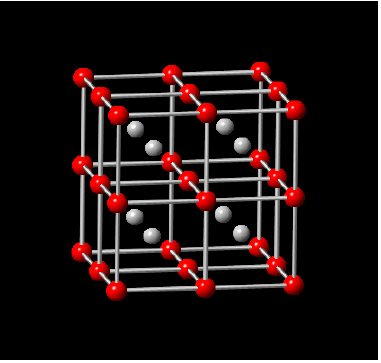
Figure 1. Schematic diagram of grid nodes of bilinear interpolation method for calculating interface curvature.